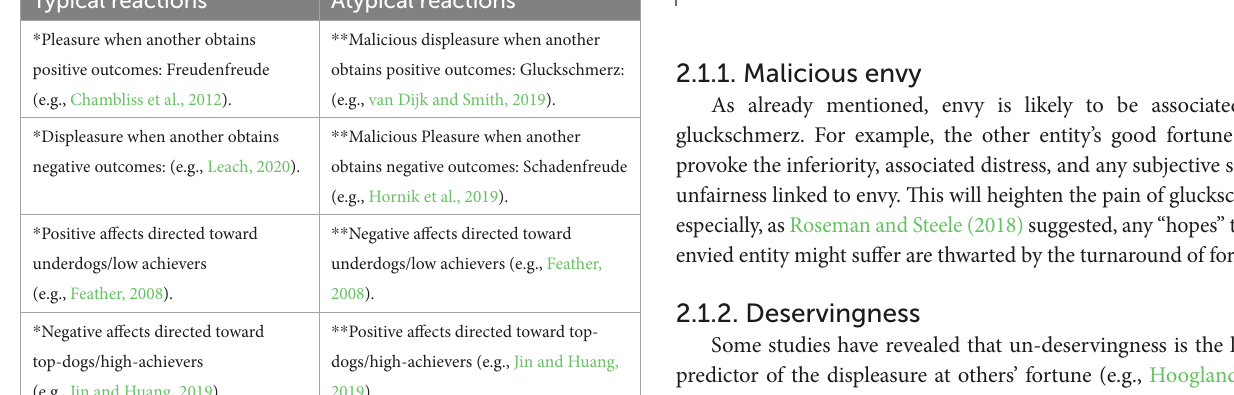
TABLE 1 Response facets in competitive situations. Typical reactions Atypical